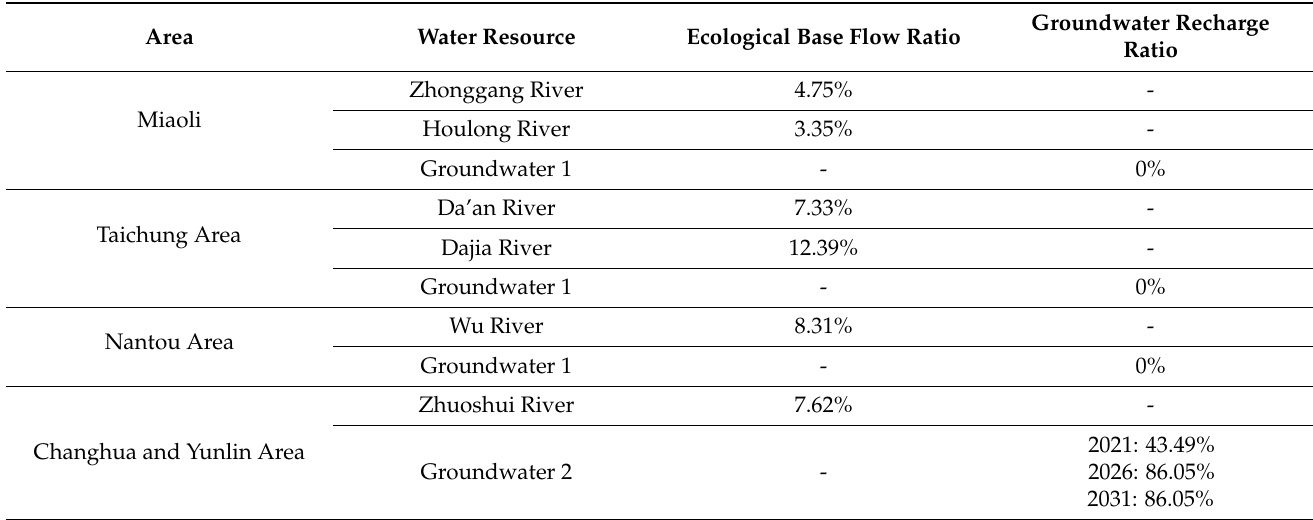
Table 2. Ratios for the Ecological Base Flow of Rivers and Groundwater Recharge by Area in Central Taiwan.